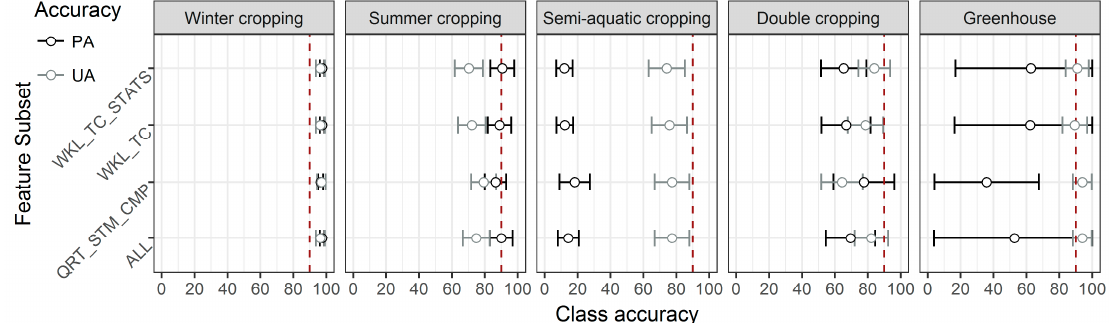
Figure 3. Area-adjusted producer’s (black) and user’s accuracies (grey) for the selected models. Error bars indicate 95% confidence intervals. Vertical dashed lines mark 90% accuracy.